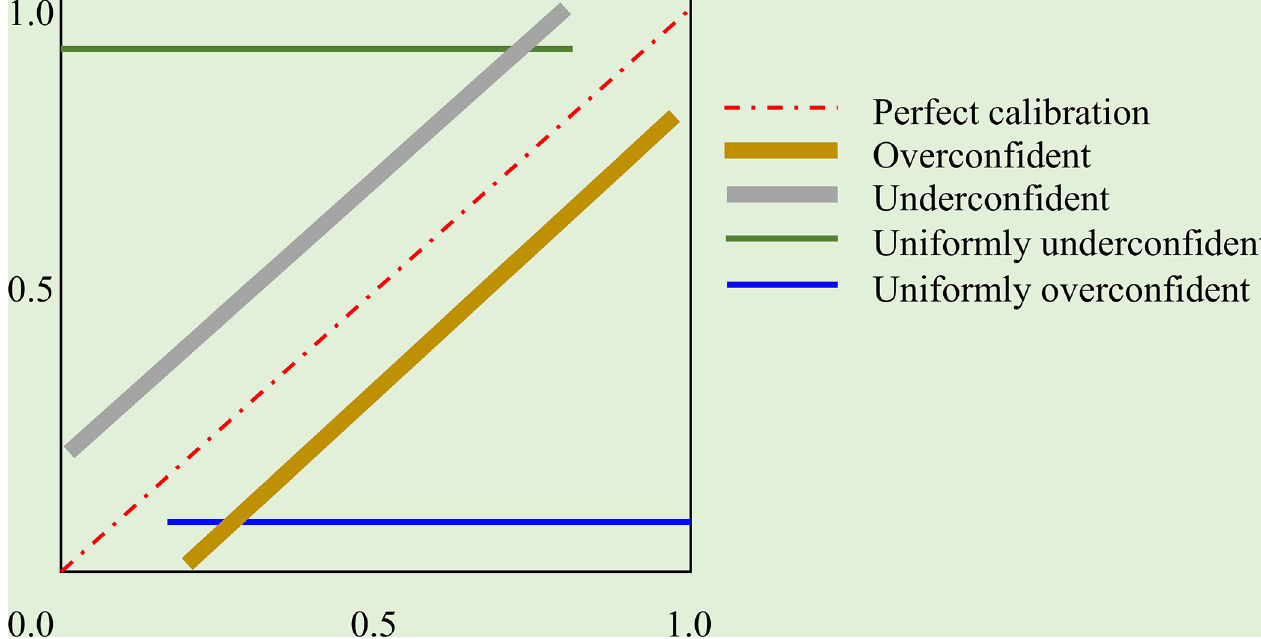
Fig 2. A sample sketch of the reliability diagram shows perfectly calibrated, overconfident, underconfident, uniformly overconfident, and uniformly underconfident predictions.